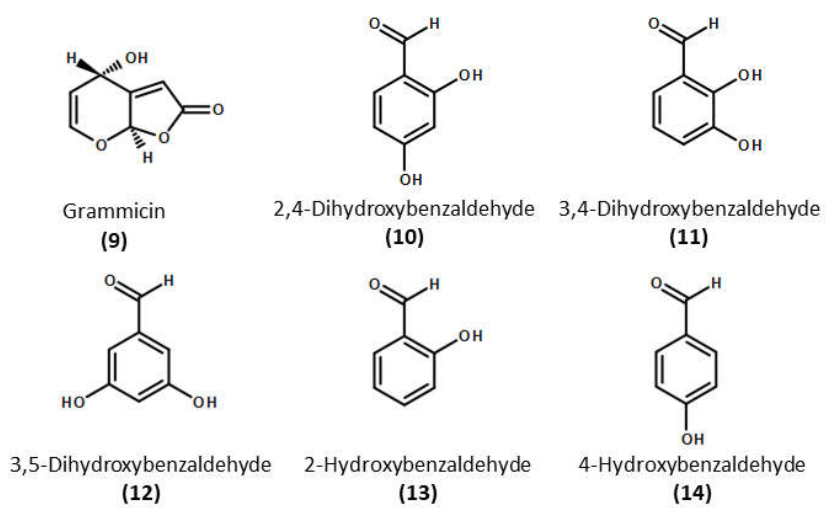
Figure 4. Chemical structure of the hydroxybenzene derivatives (compounds 9 – 14 ) used in this study.